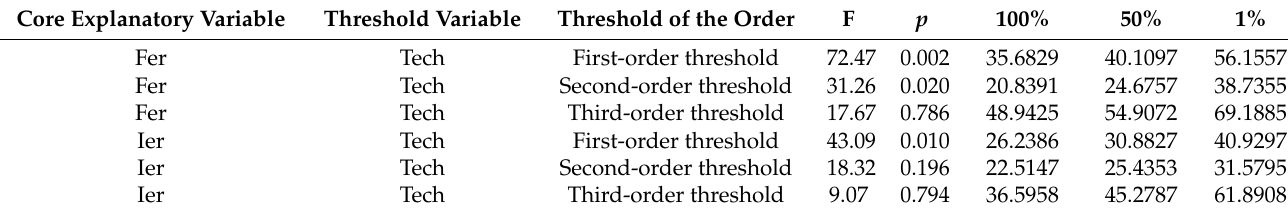
Table 5. Threshold regression test